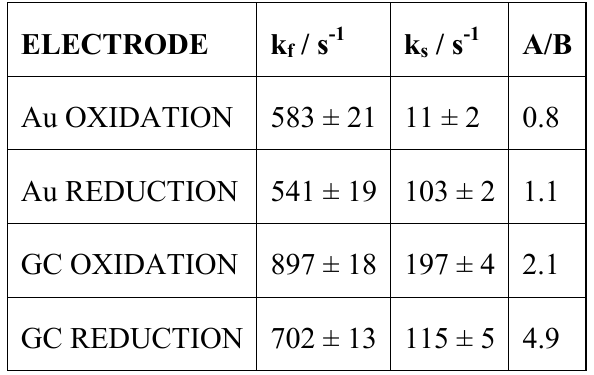
Table 1. Four parameter NLLS Biexponential fitting of potential step chronoamperometry transients for GOx/SWCNT/Nafion modified Au and GC